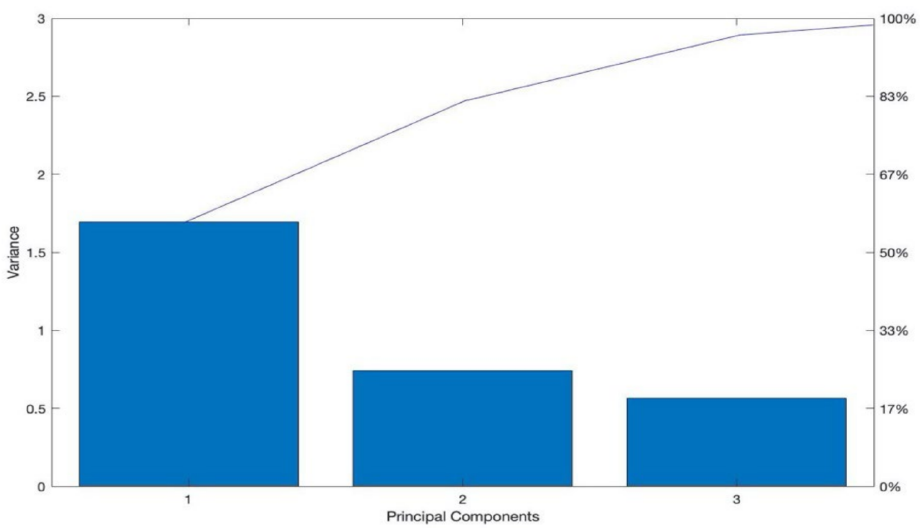
Figure 3. The time evaluation of fault-free data.